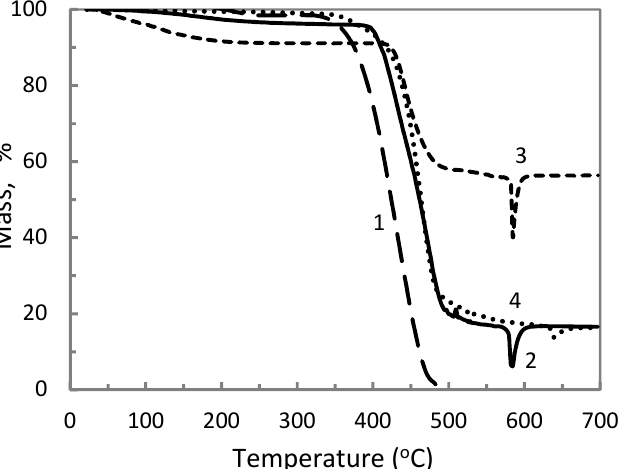
Figure 6. Thermogravimetric curves of ETFE/AP composites with the following compositions: 100/0 (1), 70/30 (2), 30/70 (3), and 50/50 (4) (wt %).